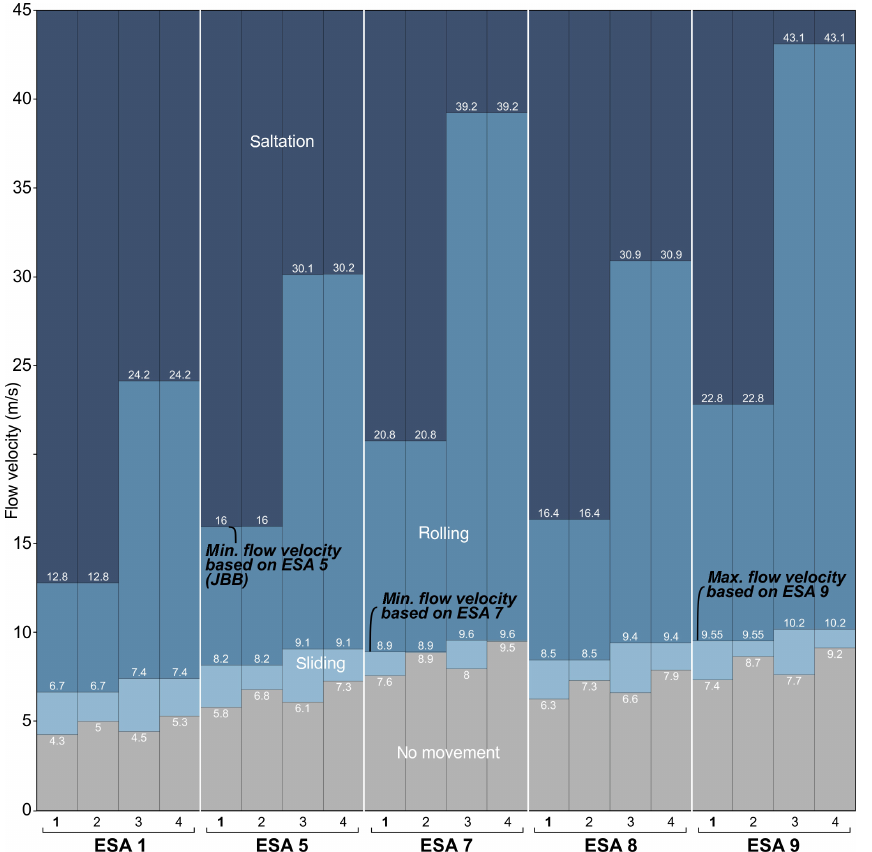
Figure 7. Flow velocities calculated for transport of largest clasts at site ESA. For each clast, flow velocities were calculated with different coefficients taken from the literature (cases 1–4 on x axis): 1 – C l = 0.178, µ = 0.7; 2 – C l = 0.178, µ = 1.02; 3 – C l = 0.05, µ = 0.7; 4 – C l = 0.05, µ = 1.02 (Nott, 2003; Noormets et al., 2004; Benner et al., 2010; Nandasena et al., 2011). For case 1, minimum flow velocities of 8.9ms − 1 were calculated for ESA 7 using Eq. (2) to initiate rolling movement as observed in the field. Since no signs for overturning were documented for ESA 9, flow velocities are assumed to have remained below 9.55ms − 1 based on Eq. (1). However, based on Eq. (3) of Nandasena et al. (2011), quarrying of ESA 5 required flow velocities of >16ms − 1 . In comparison to case 1, flow velocities calculated for cases 2–4 differ in the order of 1.0–1.9ms − 1 (for the initiation of sliding) and 0.7–0.9ms − 1 (for the initiation of rolling). Remarkably higher flow velocities for the initiation of saltation are calculated with C l = 0.05 (cases 3 and 4).